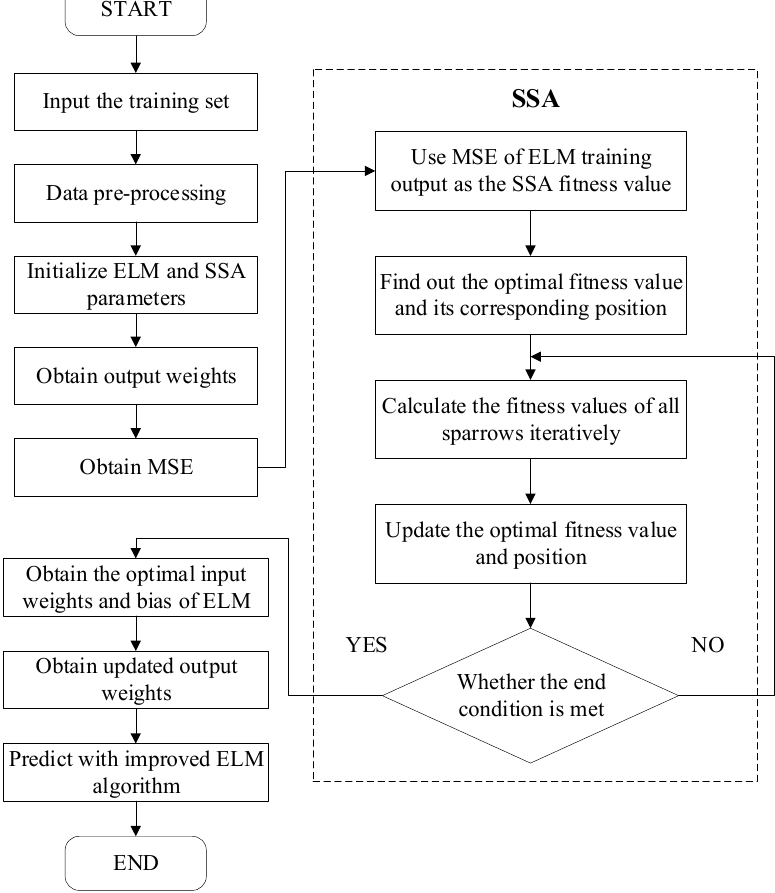
Figure 5. SSA-ELM algorithm flow chart.